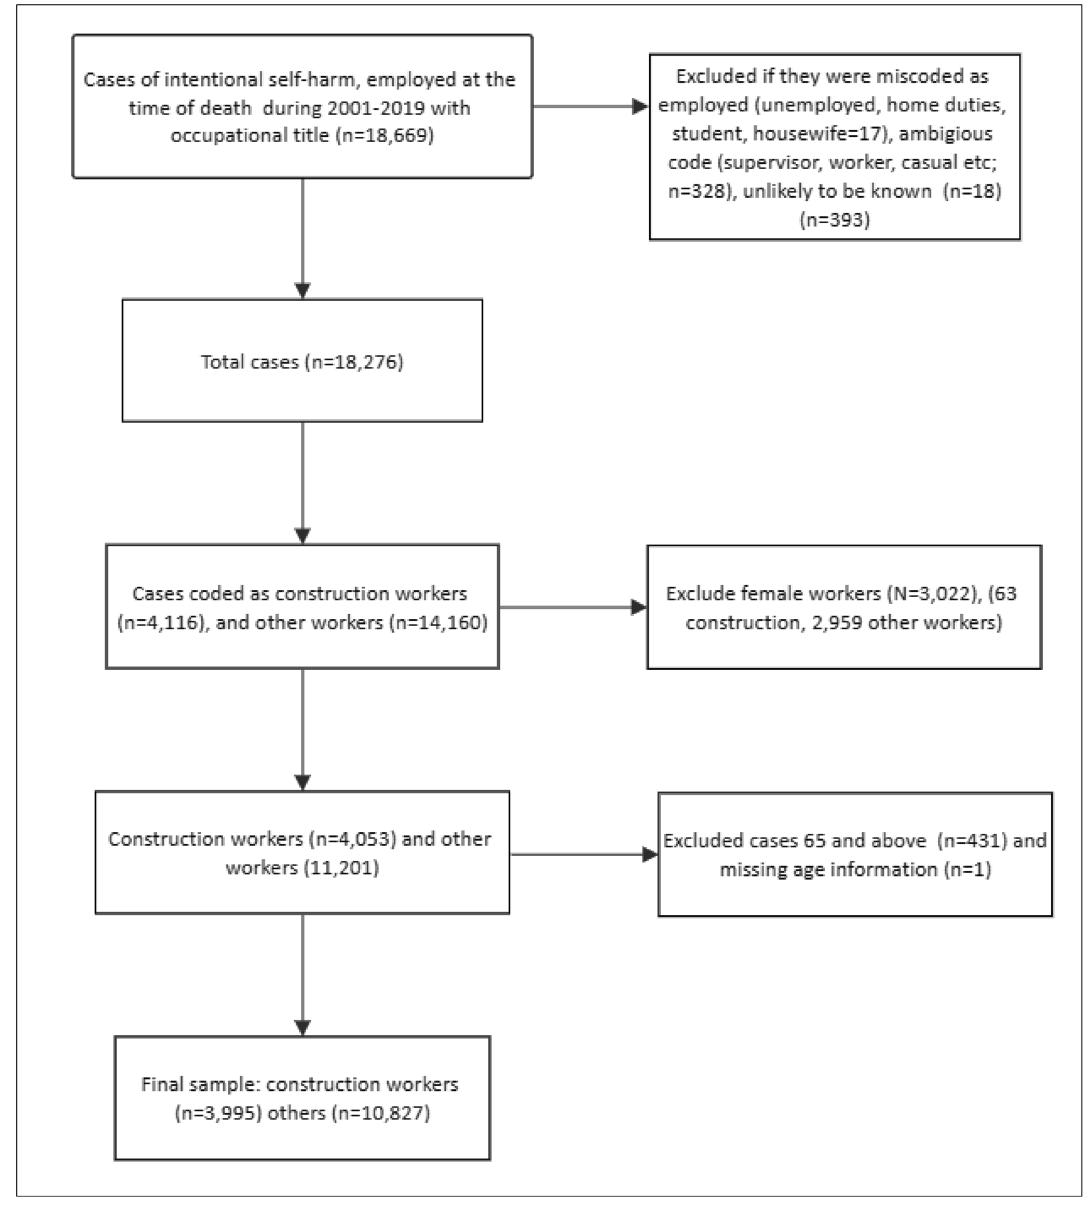
Figure 1. Flow chart for case